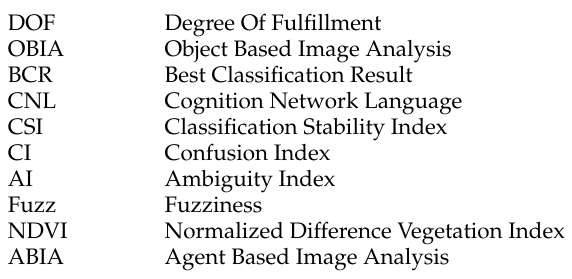
Figure S1: Use of customized algorithm “Defuzzification Indices” in the eCognition process tree, Figure S2: Rule set loaded and applied in eCognition Trial 9.1.3. before